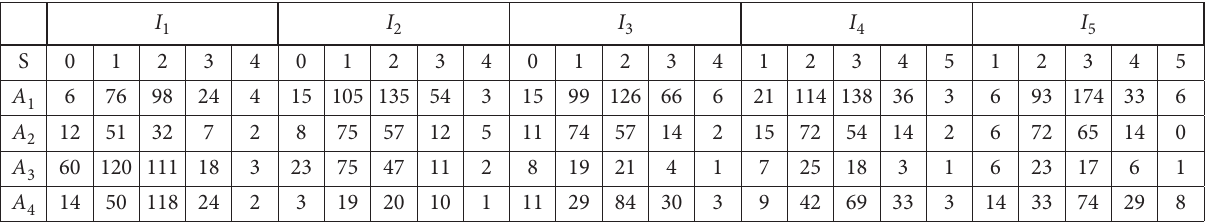
Table 5. MIMS information for online reviews of public property service quality